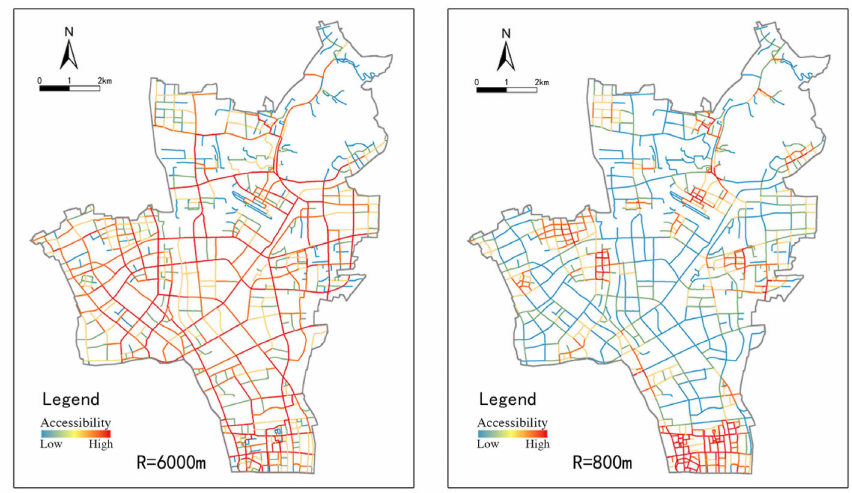
Figure 19. Street accessibility evaluation.